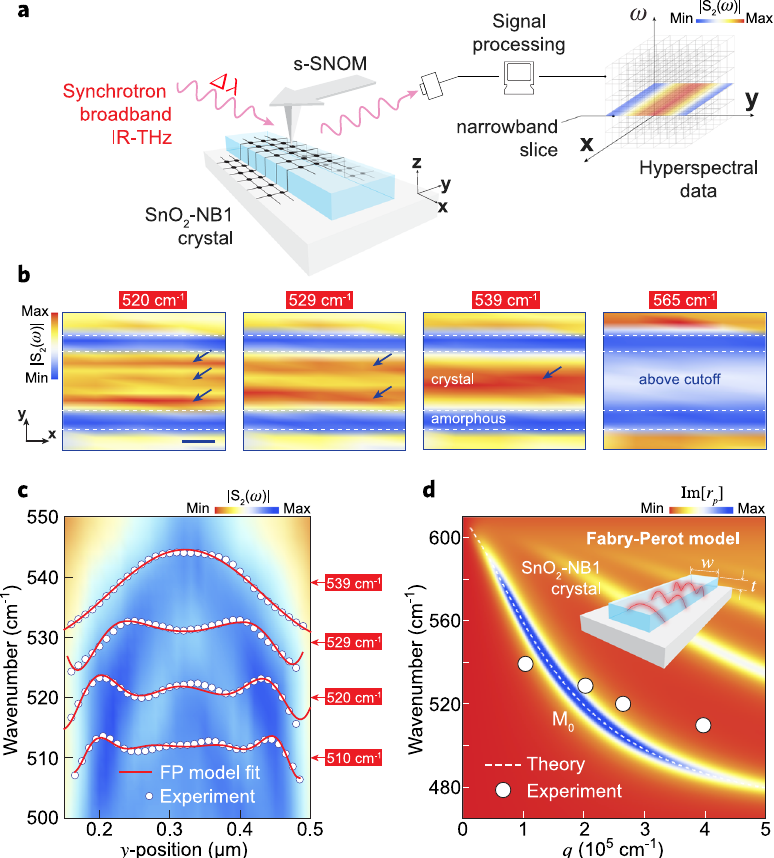
Fig. 3 Experimental visualization of cavity modes in SnO 2 -NBs. a Schematic of the SINS experiment for broadband IR-THz ( Δλ ) hyperspectral imaging. b SINS amplitude S 2 ( ω ) narrowband maps (10 cm − 1 spectral width) reconstructed from a full hyperspectral image of SnO 2 -NB1/Au for the frequencies 520, 529, 539, and 565cm − 1 . Horizontal white-dashed lines delimit crystalline and amorphous phases of the NB. Blue arrows guide the eyes highlighting the interference fringes formed by HPhP waves inside the SnO 2 -NB1 crystal. Scale bar represents 200 nm. c Spectral linescan (false-color map) superposed by SINS amplitude pro fi les (white circles) extracted from Fig. 2e. Red solid lines represent the FP model fi tting (Eq. 5) of the experimental pro fi les at 510, 520, 529, and 539 cm − 1 . Amplitude pro fi les are in arbitrary units and were vertically offset for clarity. d Dispersion relation for HPhP volume fundamental mode ( M 0 ) calculated analytically from Eq. 2 through the imaginary part of the complex re fl ectivity Im ½ r p (cid:3) (white-dashed line). White circles represent frequency – momentum ( ω – q) values model-extracted from the fi ttings in c . Inset illustrates the cavity modes (FP model) for a NB with thickness t and width w